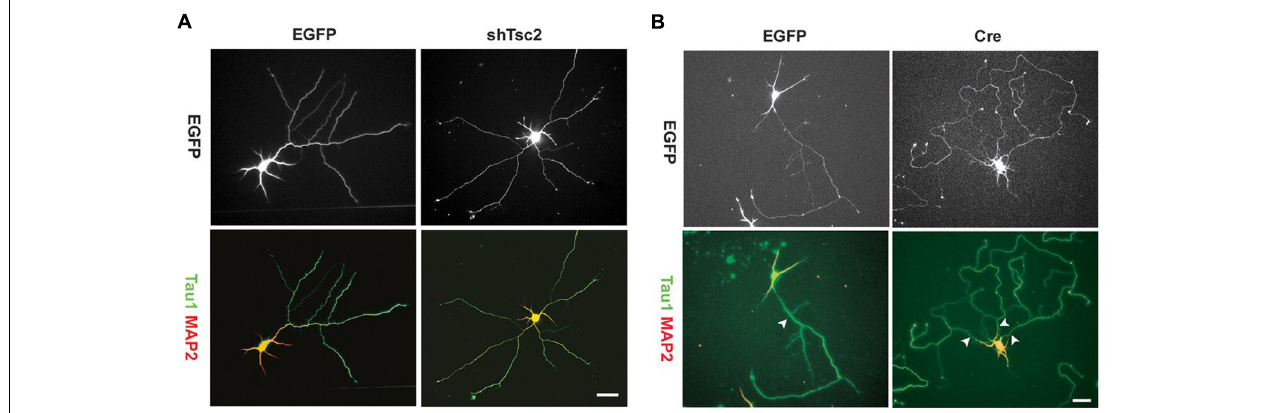
induced multiple axons, all of which are positive for Tau1. (B) E17 mouse hippocampal neurons from Tsc1 lox / flox embryos transfected with EGFP alone or EGFP together with Cre. Arrowheads indicate axons positive for Tau1. Scale bars = 20 μ m. Reprinted with permission from Choi etal.